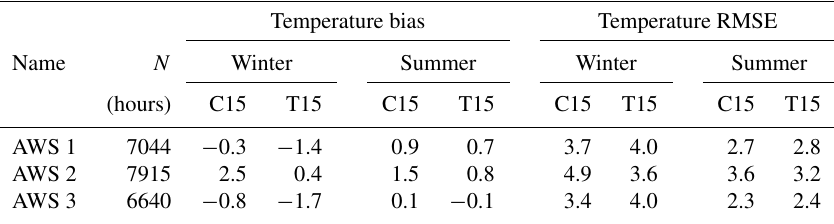
Table 6. CCLM temperature bias and RMSE for the three AWS buoys (see Fig. 2). N indicates the number of data points (hours) in 2016. Winter months are April–September, and summer months are January–March and October–December.